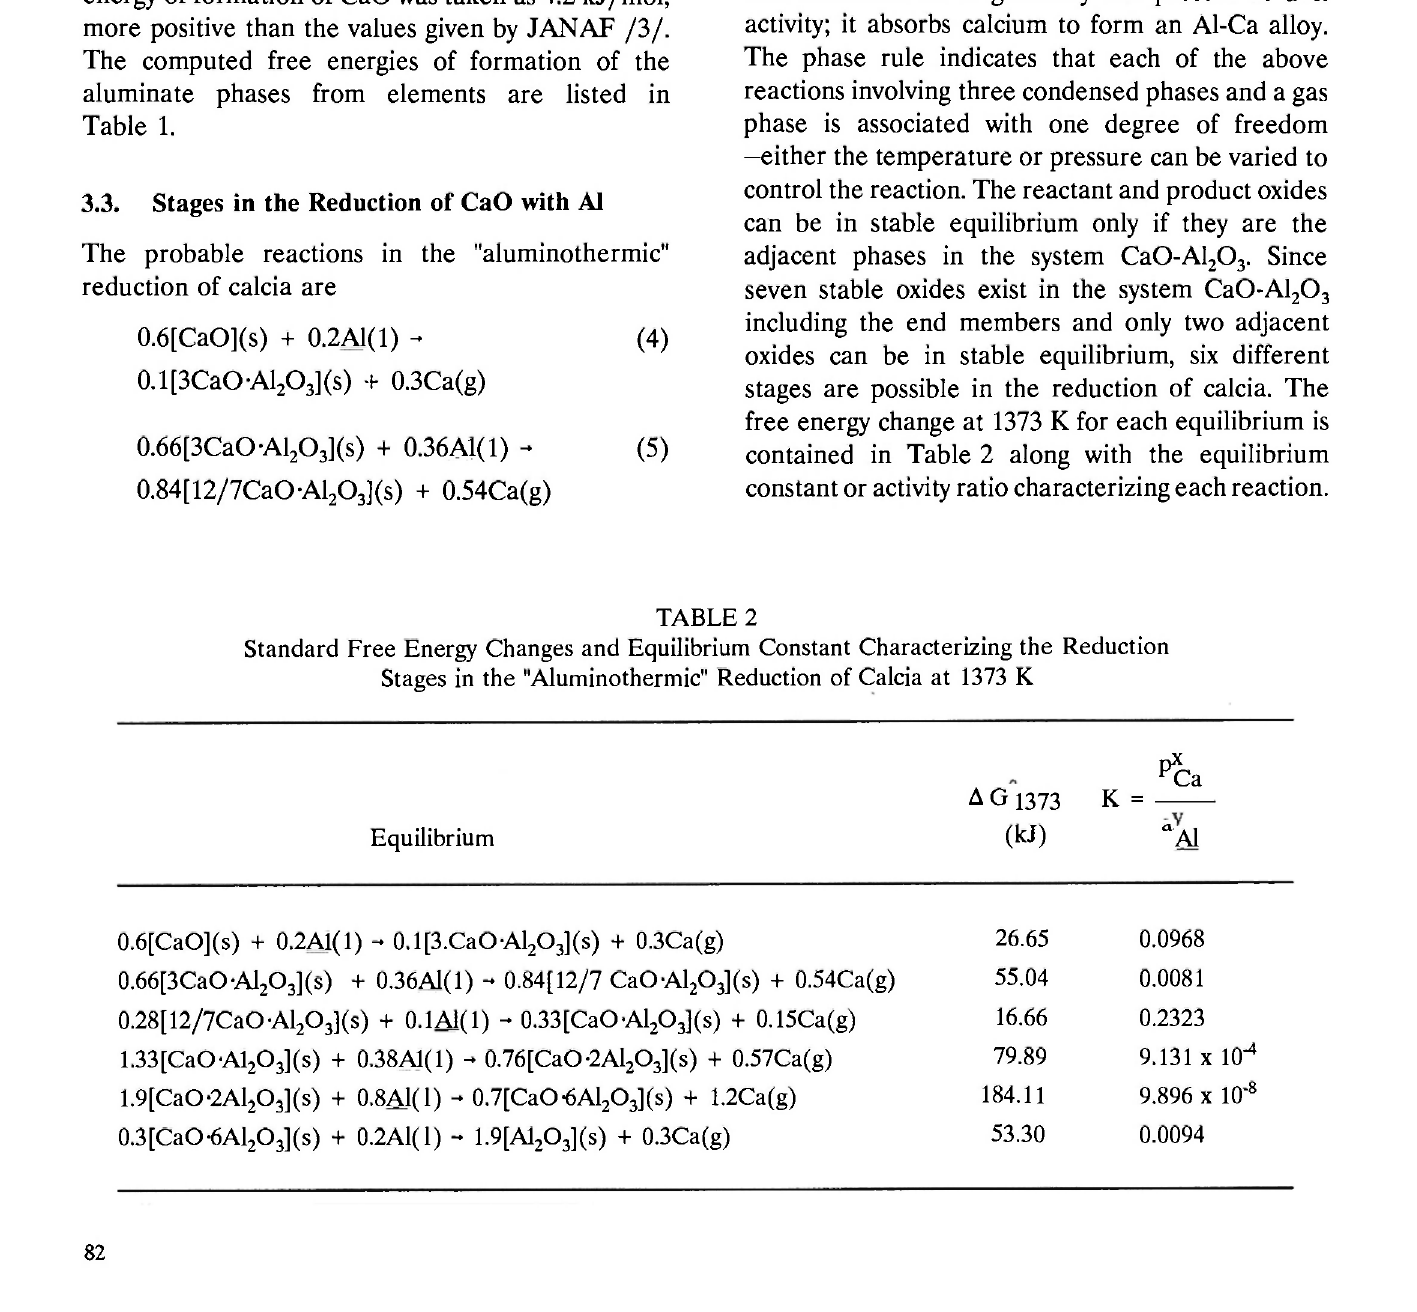
3.3. Stages in the Reduction of CaO with Al